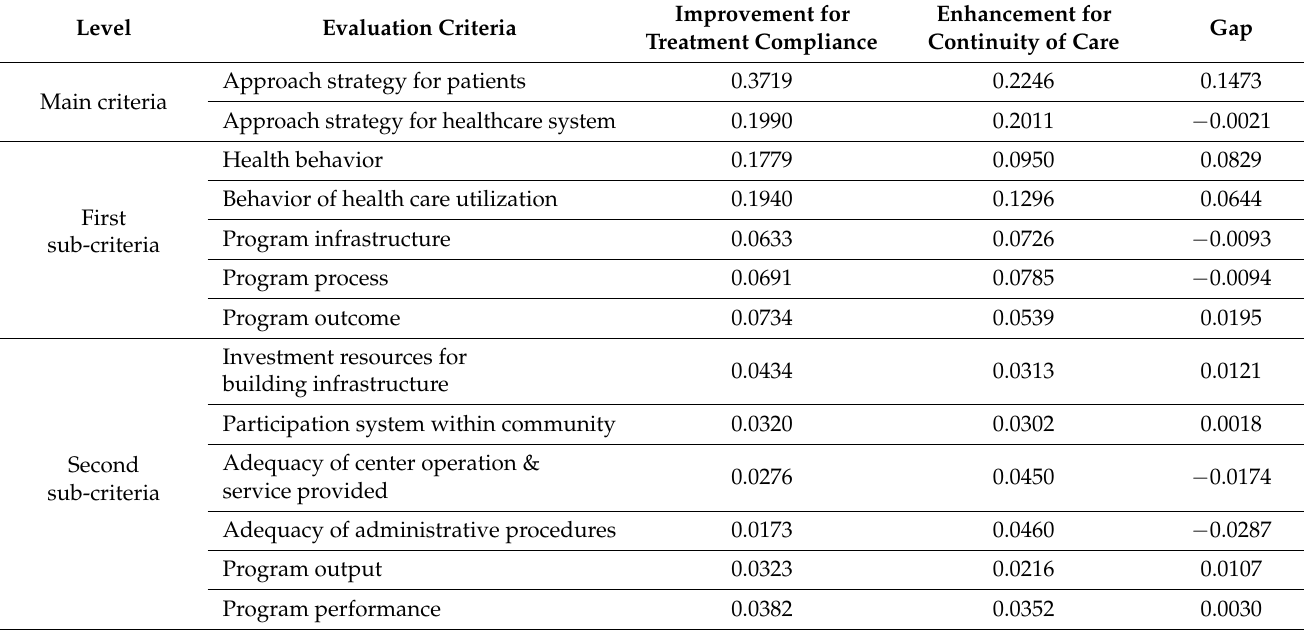
Table 6. Gap analysis of alternative priorities (alternative preference) based on evaluation